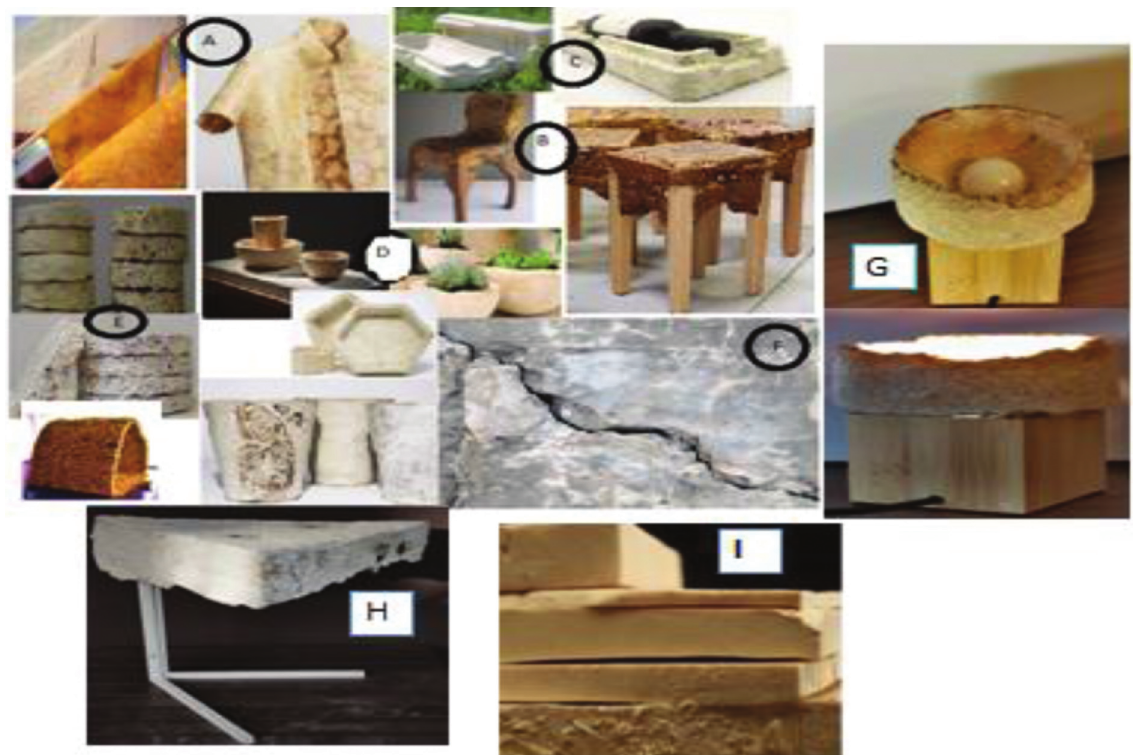
Figure 1: Different mycelium-based materials [8, 13, 24, 30, 33, 58, 62]. Leather-like materials, with companies in Indonesia, Italy, and the United States having already released promotional material and prototypes in fundraising campaigns, and they are twice cheaper than convectional materials (a). Lightweight mycelium-based composites, despite their load-bearing capability and durability, led the designers to explore designing various furniture by cultivating mycelium, such as chairs (b). Mycelium-based packaging as an environment-friendly alternative to plastic-based foam packaging (c). Light and low-density kitchenware and pots as biodegradable and recyclable alternatives to single-use plastics (d). Blocks made of mycelium substrate complex, partition wall, and indoor construction (e). Fungus used for self-healing of cracks through calcite production (f). Mycelium-based light fixture to enhance lamp light reflection (g). Coffee table with mycelium-based tabletop (h). Flexible mycelium-based polymer-like material (foam)